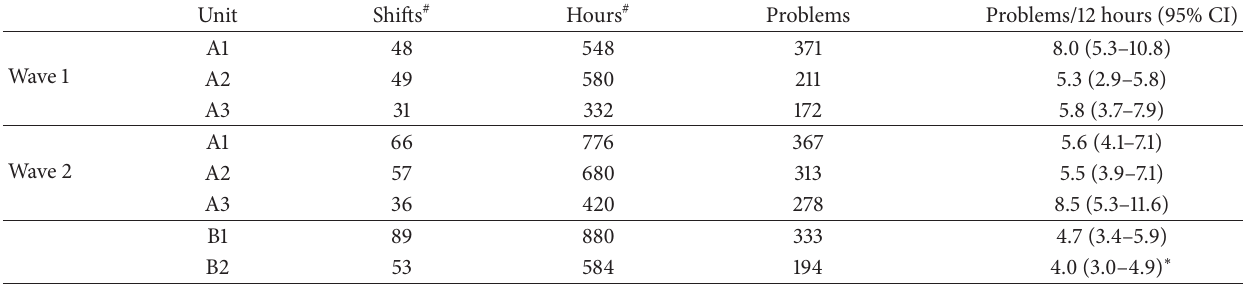
Table 2: Staff shifts, hours worked, and problems reported.